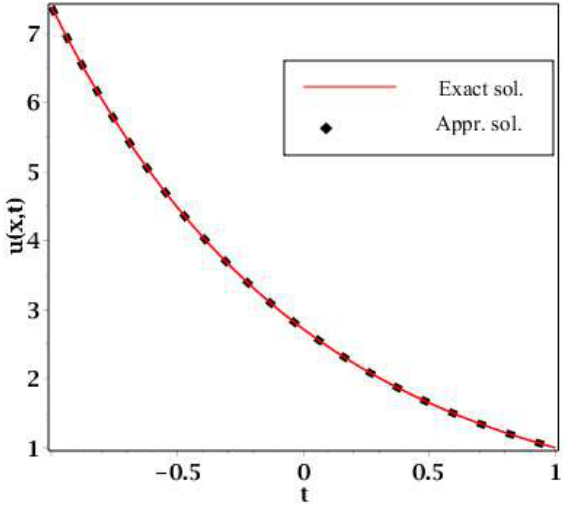
Fig. 1: Comparison between exact solution and approximate solu- tion for α =